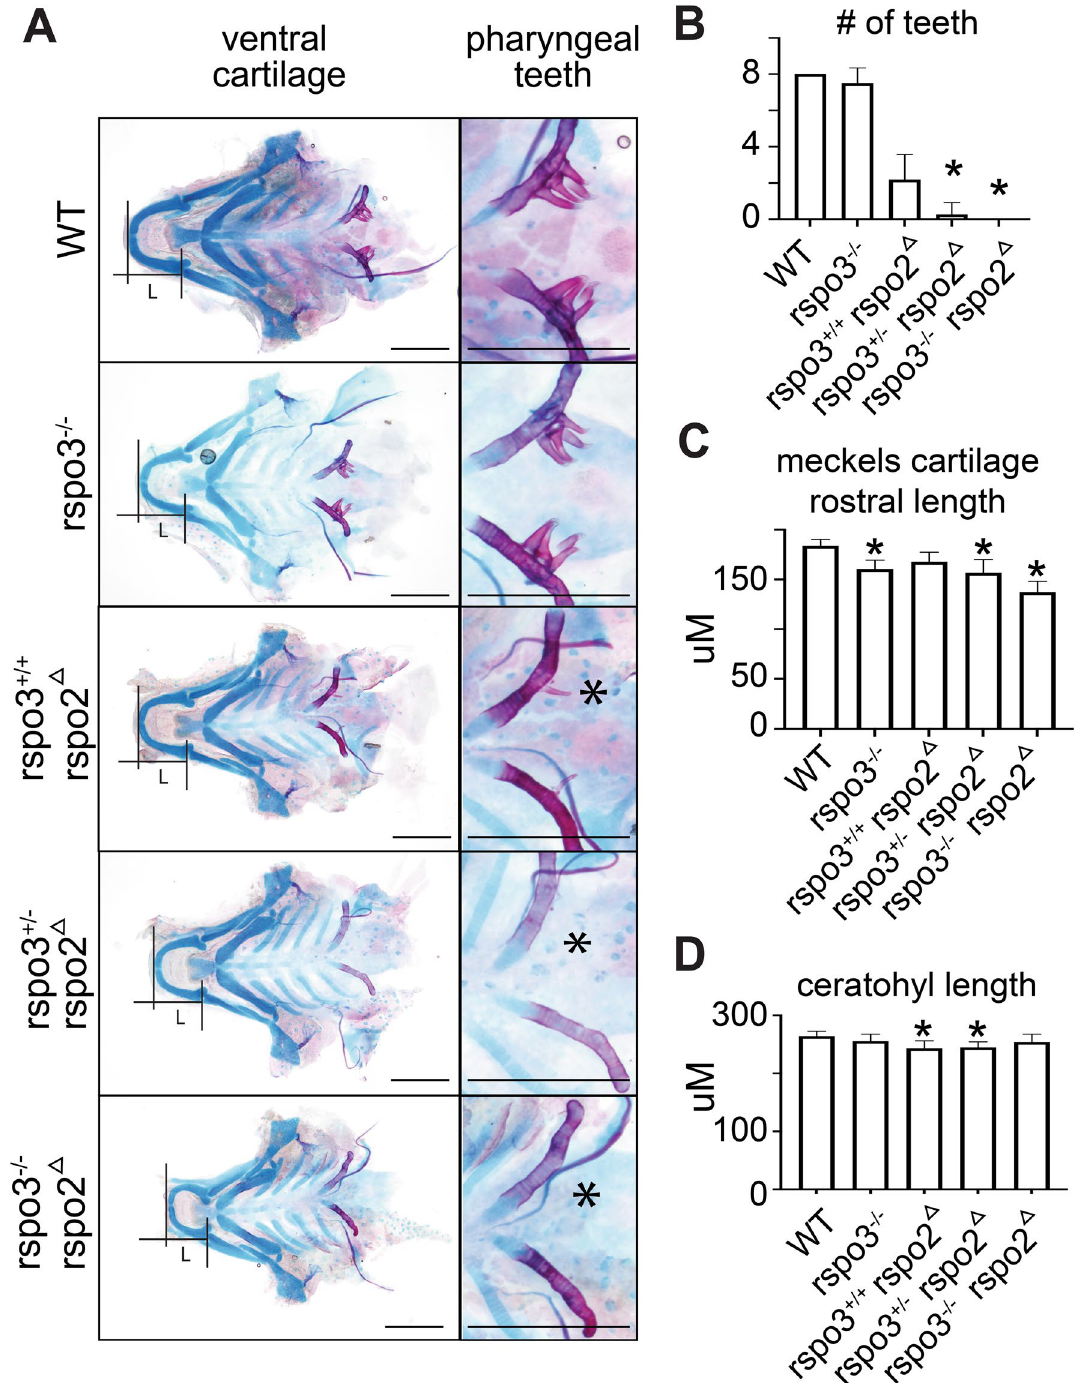
Figure 5. Synergistic effect of rspo2 and rspo3 ablation on zebrafish tooth development and Meckel’s cartilage. ( A ) Flat-mount images of Alcian blue/Alizarin red S stained 9 dpf zebrafish ventral cartilages. Zoom of pharyngeal teeth to right. rspo3 −/− larvae displayed anterior shortening of Meckel’s cartilage, which was exacerbated with rspo3 −/− ; rspo2 Δ gRNA disruption (black bars). *indicate absent teeth. Scale bar: 200 μm. ( B ) Alizarin red S staining of pharyngeal teeth shows that rspo3 −/− are generally normal relative to wild-type while rspo2 Δ larvae have a reduced number of teeth (average of 2 versus 8). Tooth number in rspo2 Δ larvae decreased further with decreasing wild-type alleles of rspo3 (zero teeth detected in rspo3 −/− ; rspo2 Δ mutant). ( C ) Quantification of the anterior–posterior/rostral length of Meckel’s cartilage shows a primary effect in rspo3 −/− larvae, which is exacerbated in rspo3 −/− ; rspo2 Δ mutants. ( D ) Quantification of the anterior–posterior length of ceratohyal cartilage shows no effect in rspo3 −/− larvae, suggesting a cartilage element-specific effect of rspo3 and rspo2 . N = 10–16. p < 0.01. *Indicates significance relative to